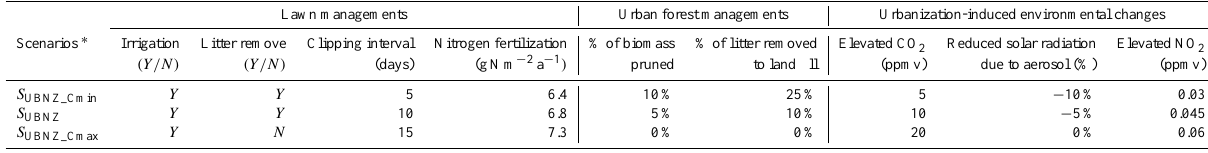
Table 2. The parameters of urban managements and urban-induced environmental changes. Lawn managements